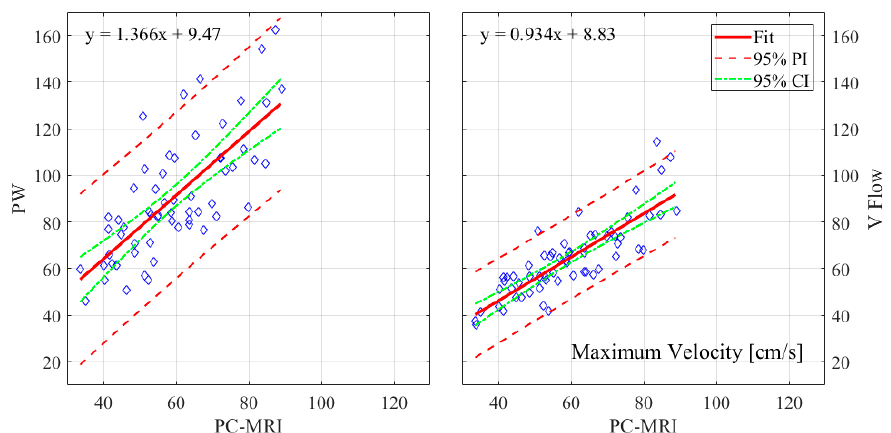
Figure 5. Linear regression plots of maximum velocities with 95% PI and 95% CI for PW and V Flow relative to PC-MRI.